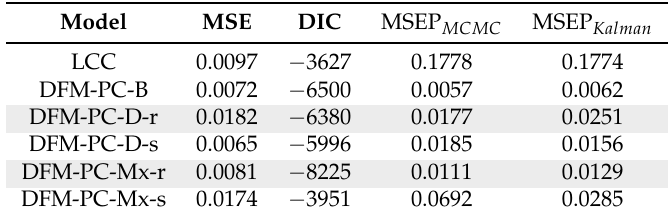
Table 4. Mean square error of the fit of the models to the data (MSE), deviance information criterion (DIC) and mean square errors of predictions using forecasting distributions given by MCMC samples (MSEP MCMC ) and Kalman Filter (MSEP Kalman ). Model MSE DIC MSEP MCMC MSEP